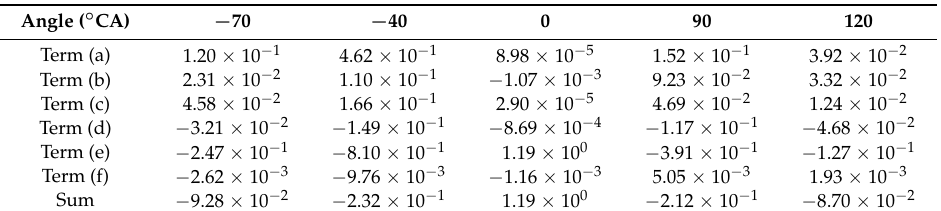
Table 2. Values of terms dependent on the TDC